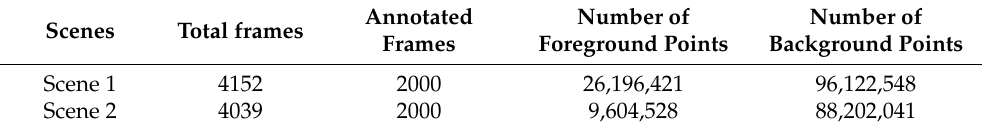
Table 2. The numbers of frames and annotations in two